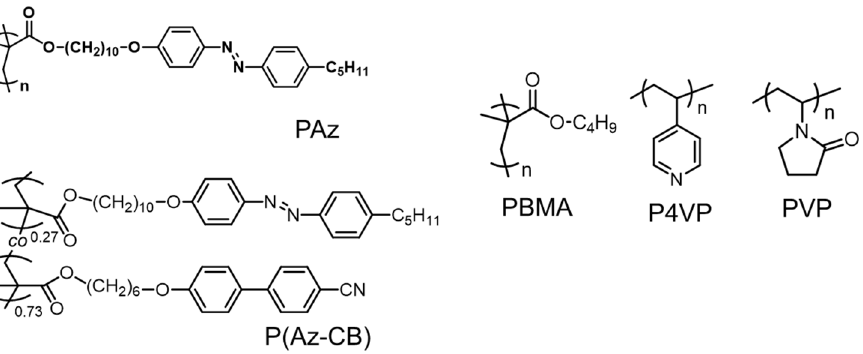
Table 1. Molecular mass data of the polymers.